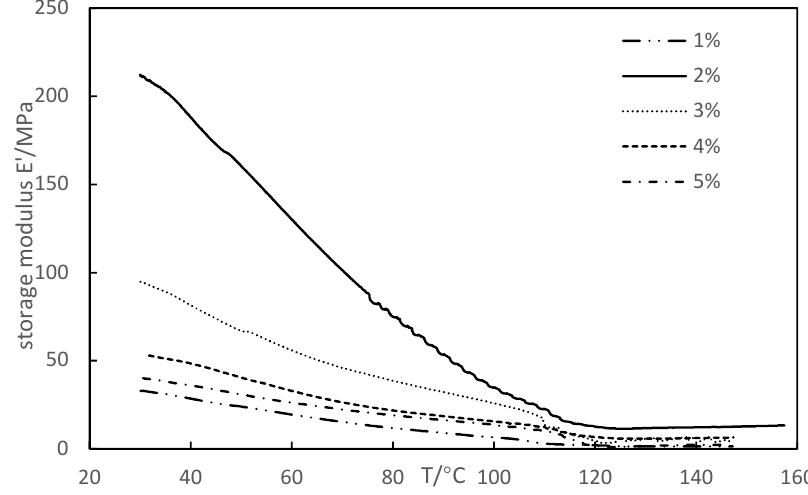
Figure8. Figure 8. Storage modulus–temperature relationship of the composite with increasing 3-MPS-treated GF.